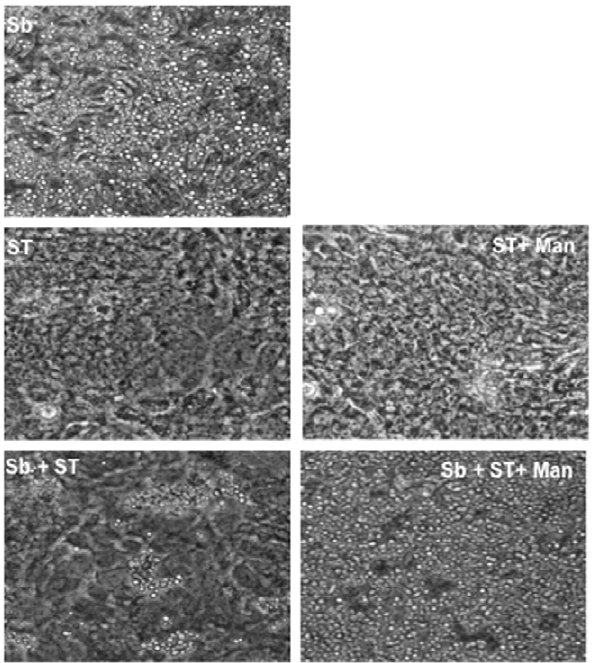
Figure 6. Phase-contrast microscopy showing agglutination between S. boulardii (Sb) and S . Typhimurium (ST) in the presence and absence of a -D-mannose. ST ( S . Typhimurium), Sb ( S. boulardii ), Man ( a